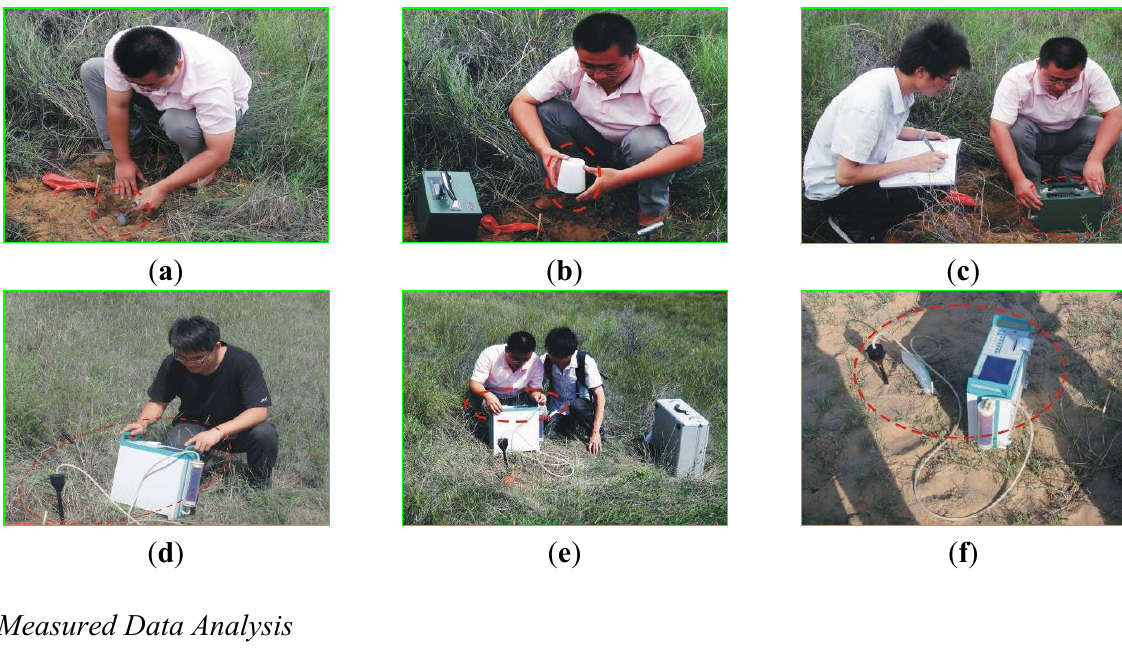
Figure 11. The technological process of on-site radon detection trial: ( a ) dig the small pit; ( b ) lay the DC; ( c ) measure the counts; ( d ) adjust the device; ( e ) set the parameters; and ( f ) measure the